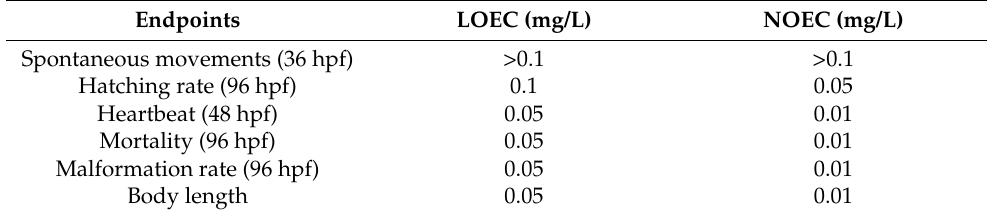
Table 5. LOEC and NOEC values of Hg 2+ to rare minnow at embryo and sac-fry